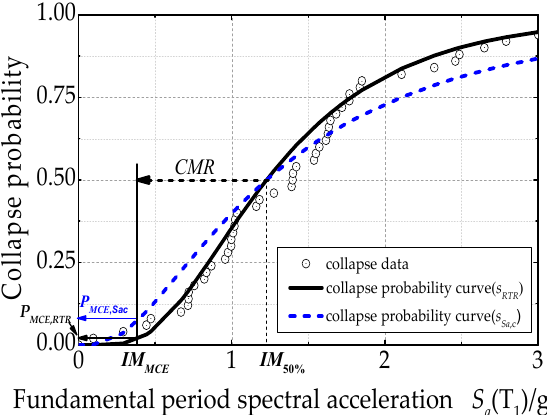
Figure 4. Collapse vulnerability curves with different collapse uncertainties.